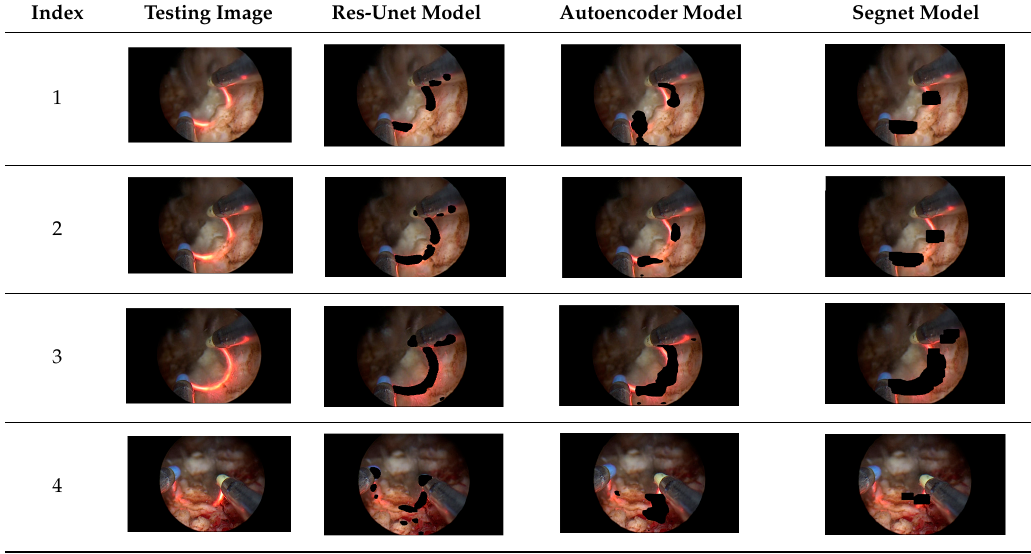
Table 10. The comparison of the mean residual coefficient score with different models.